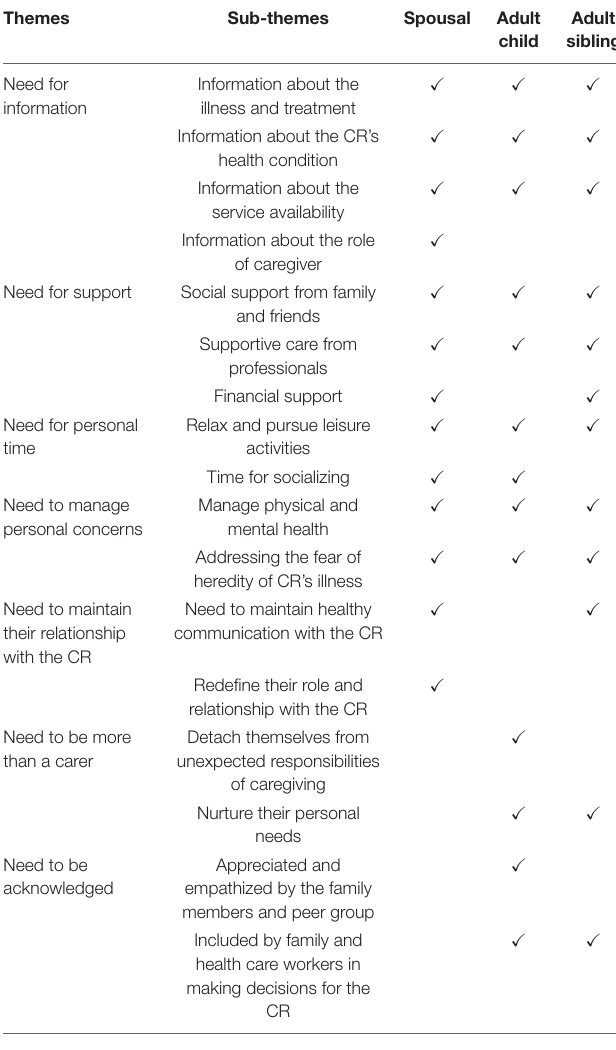
TABLE 3 | Overview of common and unique needs experienced by spousal, adult child and adult sibling